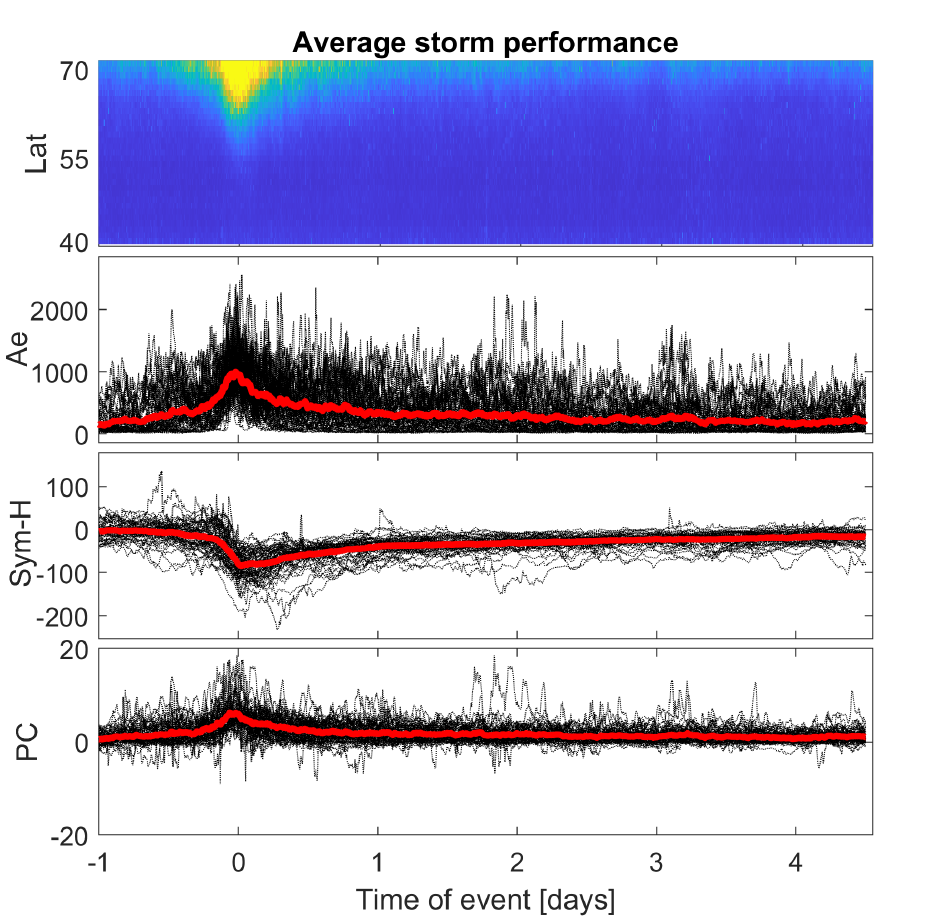
Figure 7. Average storm − time ROTI performance in comparison with averaged AE, Sym-H and PC